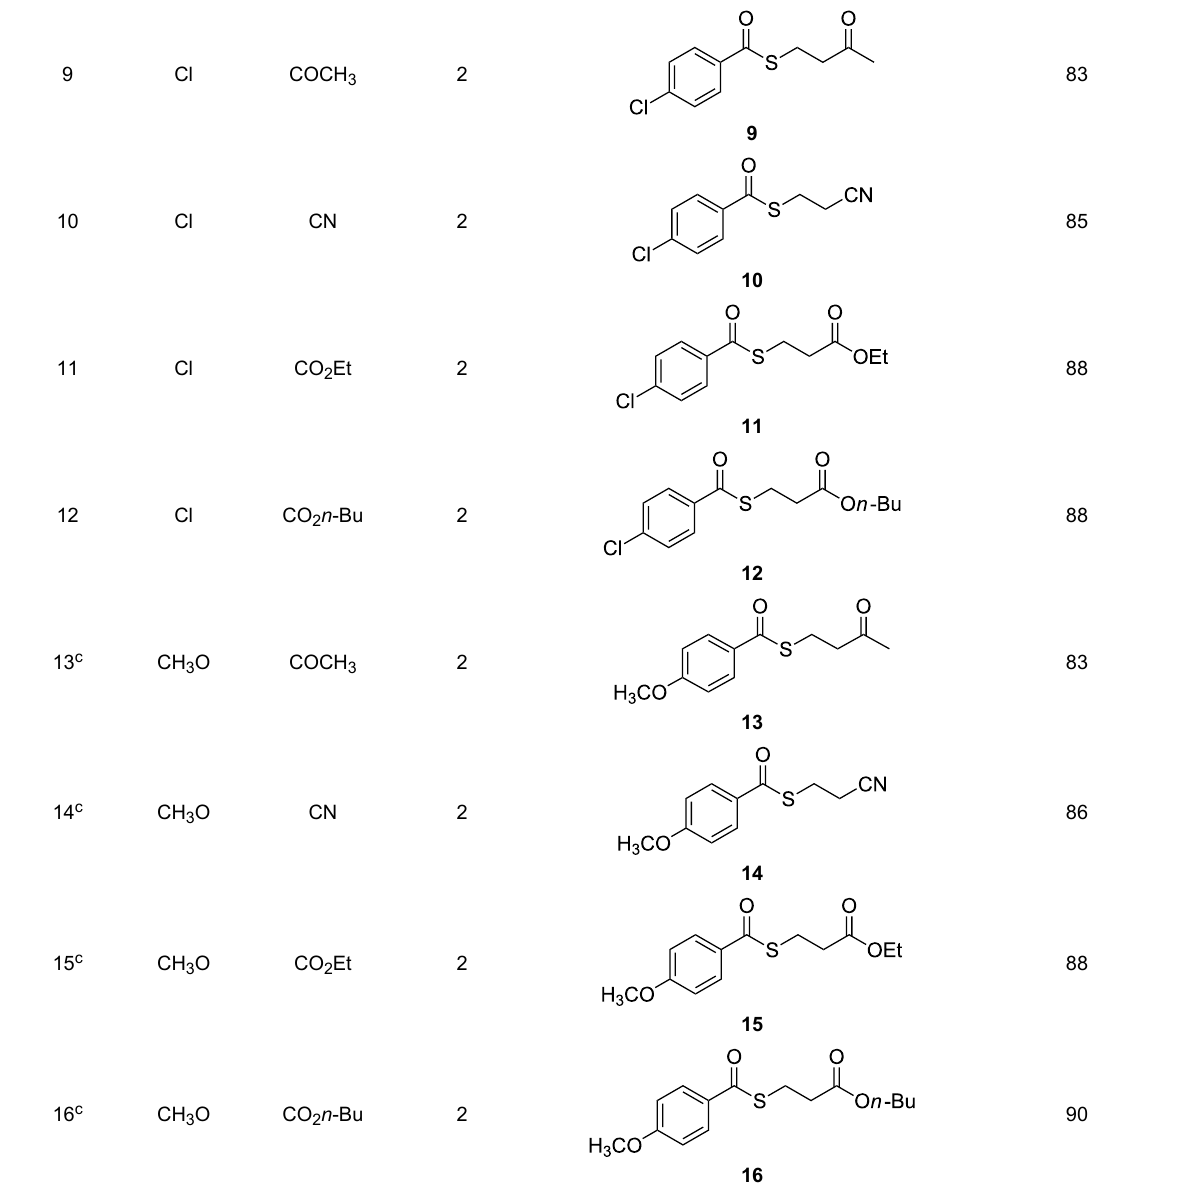
Table 1: One-pot synthesis of thioesters using benzoic anhydrides, thiourea and electron-deficient alkenes a .